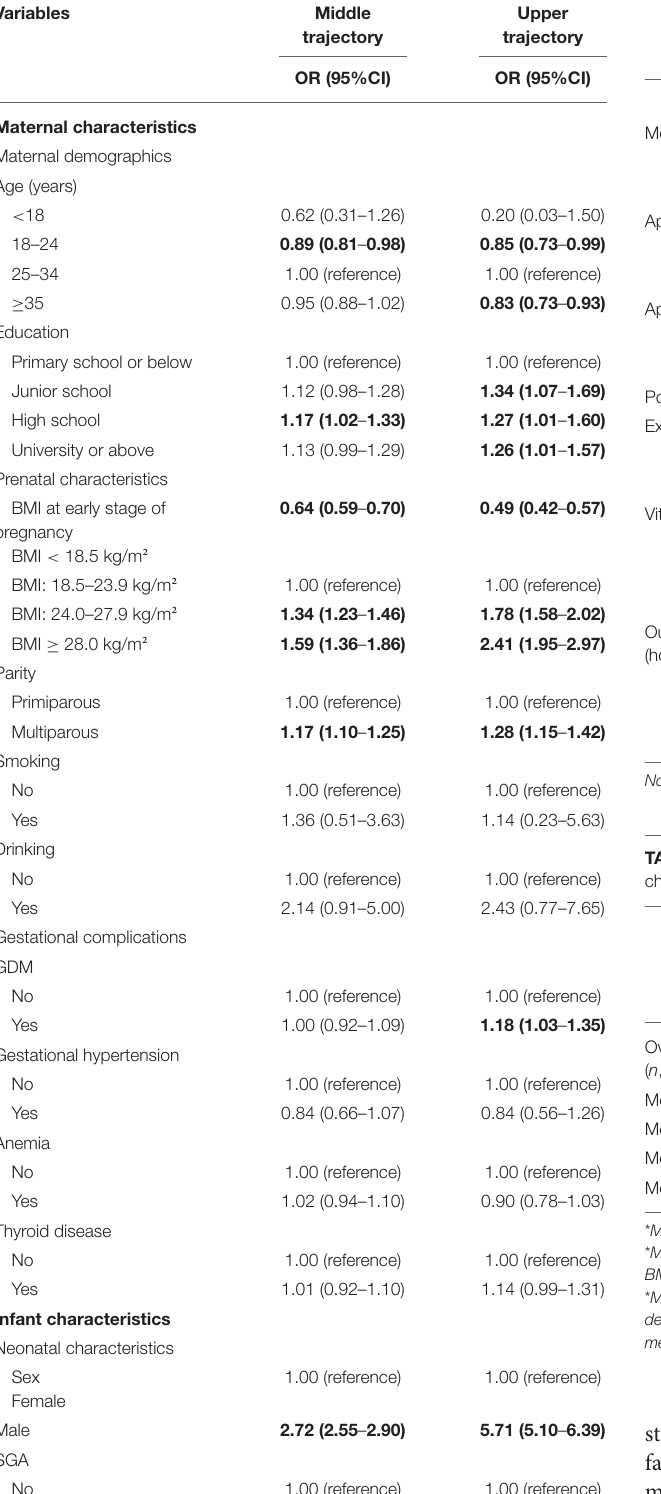
TABLE 2 | Association between prenatal and early life factors with middle and upper BMI trajectories in comparison to the lower trajectory group. Variables